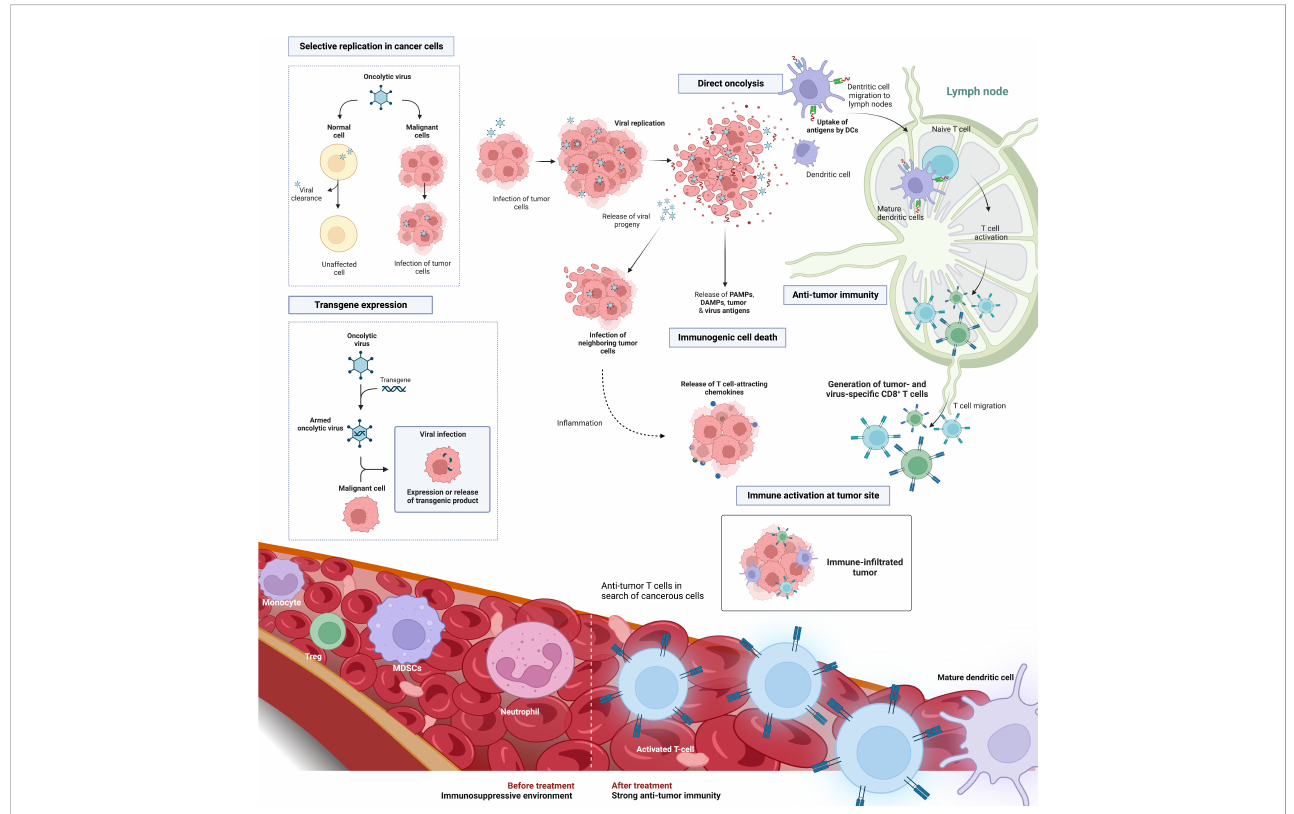
FIGURE 3 Oncolytic virus platform in the treatment of solid cancers. OVs are a versatile tumor targeting therapeutic platform involving direct tumor cell oncolysis, immune activation and transgene expression to enhance tumor lysis. Selective oncolysis enables viral replication as well as infection and lysis of both neighboring and distant tumor cells. Viral replication results in the release of both viral and tumor-associated antigens. Depending on the viral backbone, oncolysis is characterized by an immunogenic form of cell death and the release of immunomodulatory molecules such as DAMPs and PAMPs. This causes the recruitment and maturation of dendritic cells that may cross-present TAAs to CD8+T cells, hence producing TAA-speci fi c T-cell populations. These biomarkers of ICD recruit and activate tumor-targeted immune T cells that in fi ltrate the TME. OVs can also be engineered to harbor select transgenes that can further enhance tumor eradiation. Examples include immune stimulating cytokines, tumor-targeted miRNAs, and reporter genes to track viral infection. Abbreviations: OV, oncolytic virus; ICD, immunogenic cell death; DAMPs, danger associated molecular patterns; PAMPs, pathogen associated molecular patterns; TAA, Tumor associated antigen; TME, tumor microenvironment; miRNA, microRNAs. Created with